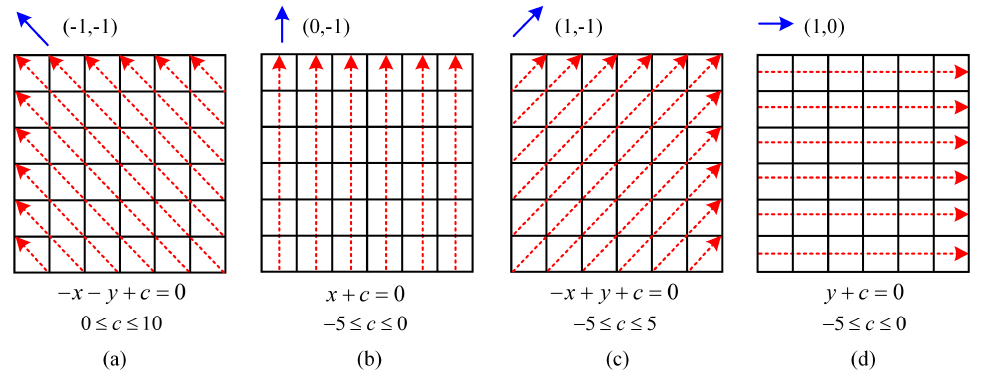
Figure 4. Using different displacement vectors to obtain numerous profile lines (PLs) from the same disparity gradient image (DGI). ( a – d ) Using displacement vectors ( − 1, − 1), (0, − 1), (1, − 1), and (1, 0), respectively.